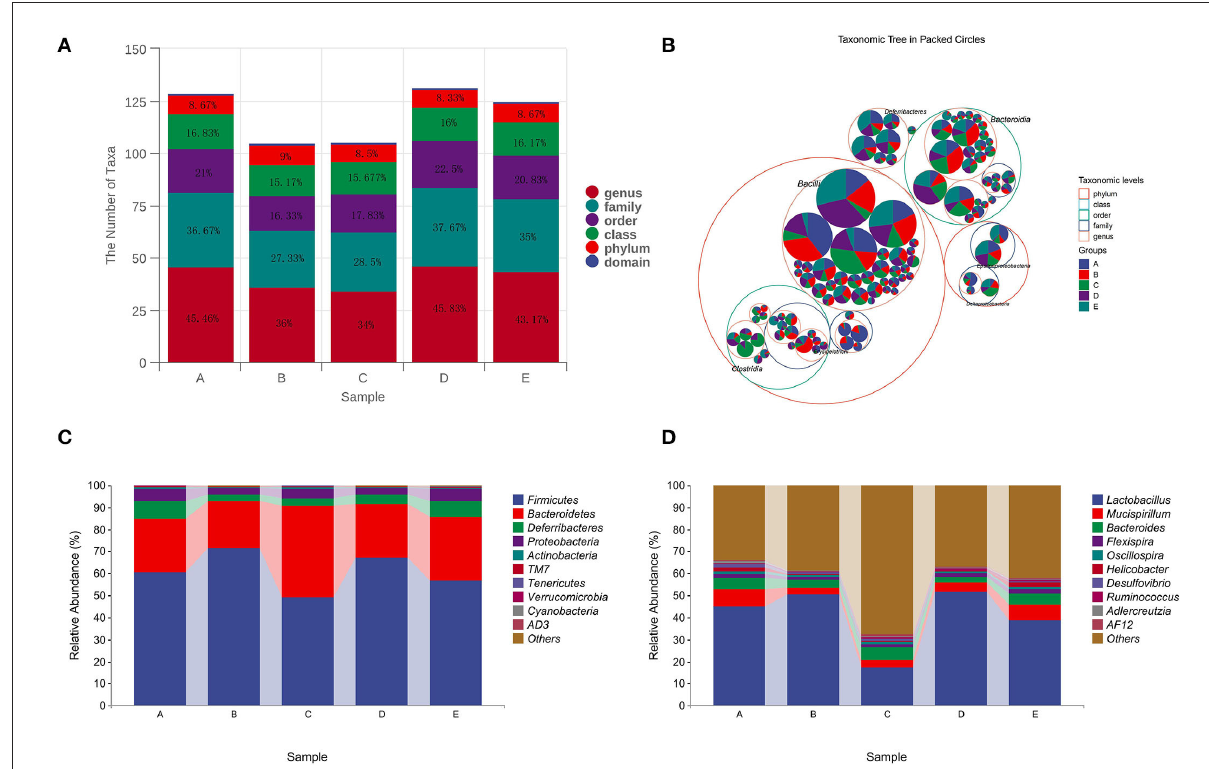
FIGURE7 Analysis of CSPCM on intestinal flora composition in mice. (A,B) The effect of CSPCM on taxonomic composition in mice samples. (C) Effect of CSPCM on intestinal flora composition at the phylum level. (D) Effect of CSPCM on intestinal flora composition at the genus